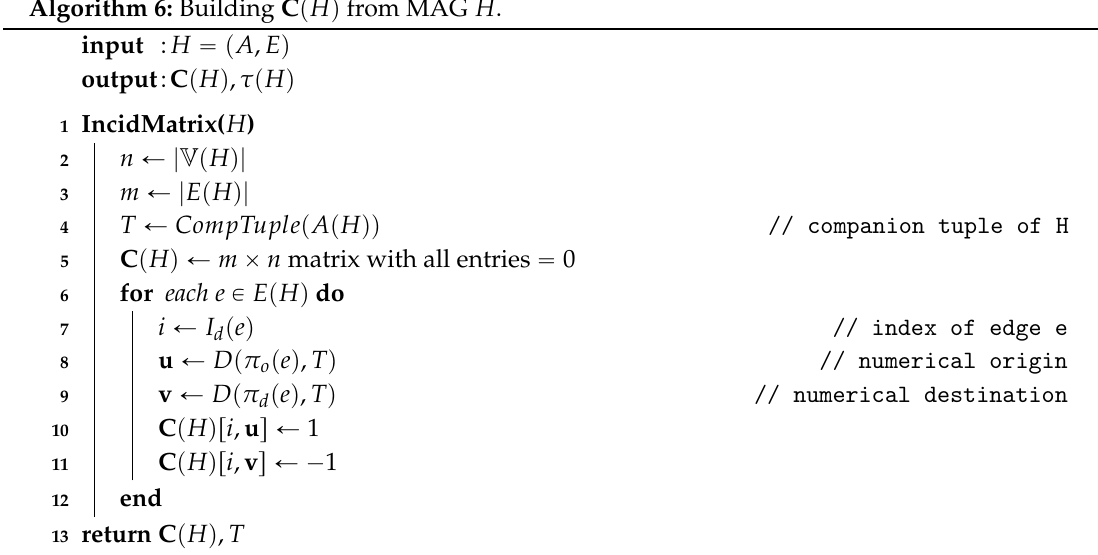
Algorithm 6: Building C p H q from MAG H